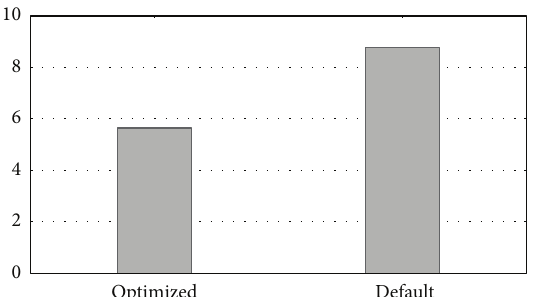
Figure 9: Runtime evolution when modifying the query cache size parameter.